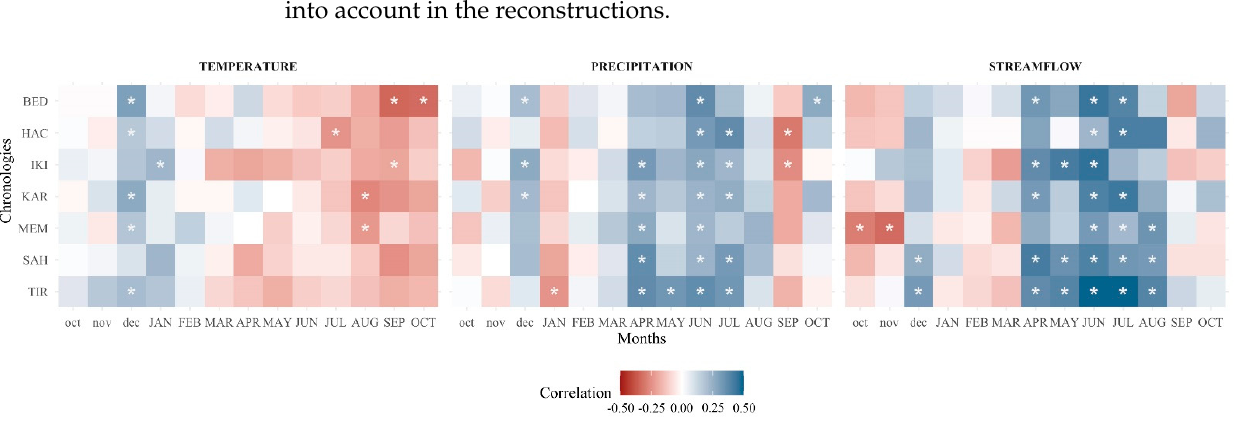
Figure 5. The correlation coefficients of climate variables with the tree-ring formations between